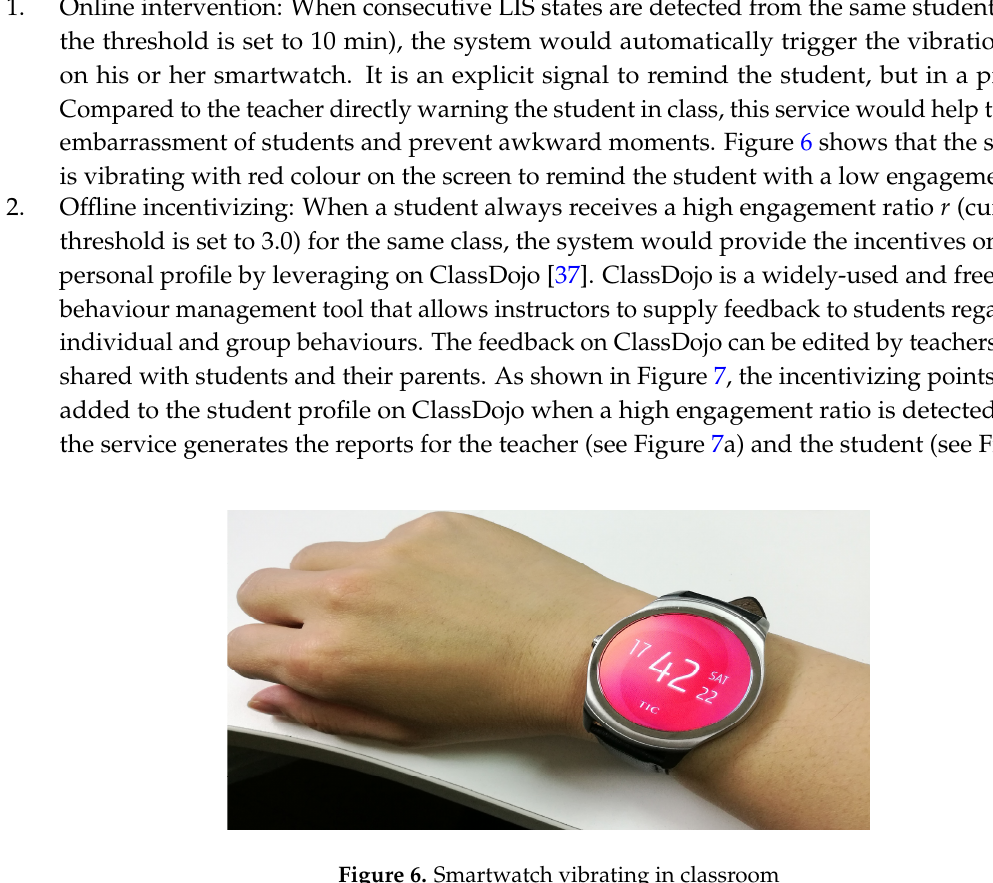
Figure 6. Smartwatch vibrating in classroom